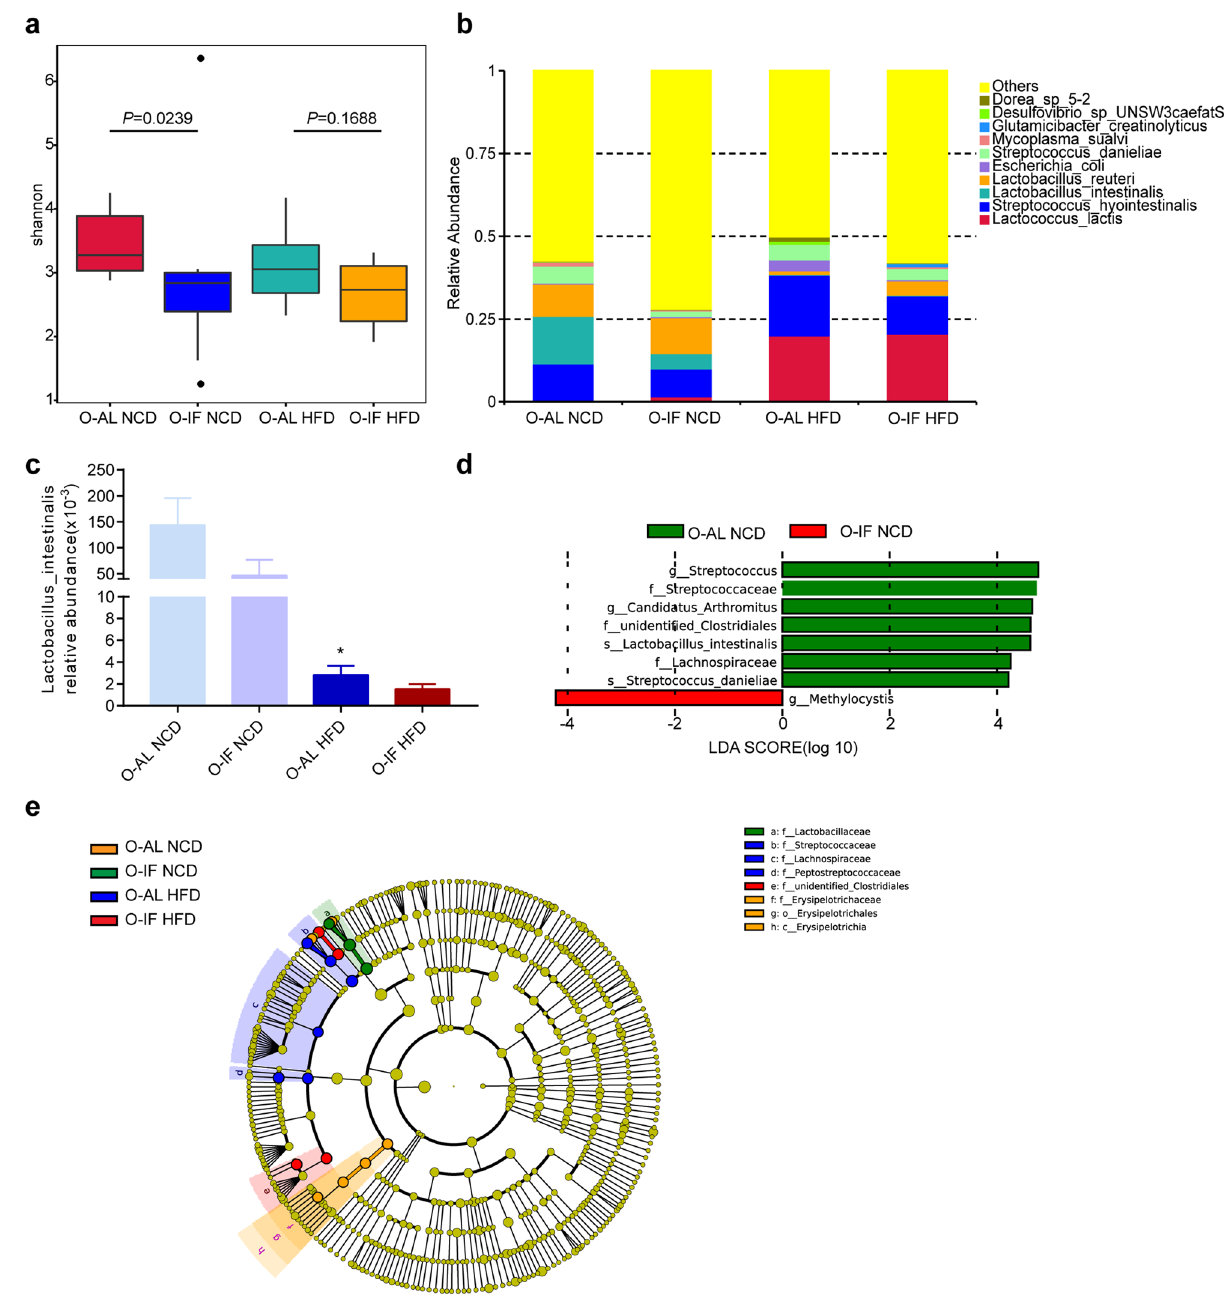
Fig. 2 Maternal intermittent fasting disrupts offspring intestinal microbiota. Six-week-old offspring of M-AL group and M-IF group were fed normal chow diet (NCD) or high fat diet (HFD) for 12 weeks. Intestinal microbiota was analyzed as described in the method section. N = 9 for O-AL NCD, 8 for O-IF NCD, 8 for O-AL HFD, and 10 for O-IF HFD. a Alpha-diversity-shannon diversity index of O-AL NCD, O-IF NCD, O-AL HFD and O-IF HFD, pairwise signi fi cance determined by Wilcoxon test. b The relative abundances of species in fecal samples. c Relative abundance of Lactobacillus_intestinalis . d The most differentially abundant taxons identi fi ed by LEfSe analysis with LDA score > 4. e Cladogram of signi fi cant changes at all taxonomic levels. The radiating circle represents the classi fi cation hierarchy from class to family. The size of node represents the abundance of intestinalis restores the intestinal barrier dysfunction in offspring of circulating triglyceride ( P = 0.0196) (Fig. 4b) were observed in maternal intermittent fasting mice. O-IF offspring. Hepatic triglyceride content ( P = 0.0456), and steatosis evidenced by H&E and oil red O staining were elevated (Fig. 4e). Fat mass and adipocyte size of perirenal white adipose tissue (rWAT), epidydimal white adipose tissue (eWAT) and subcutaneous white adipose tissue (sWAT) were increased (Fig. 4f). Administration of L. intestinalis reversed the impair- mice . We next examined the metabolic consequence of intestinal ment in glucose tolerance (Fig.4a) as well as increment in plasma barrier dysfunction in O-IF offspring fed HFD. Signi fi cant triglyceride (Fig. 4b), lipid absorption (Fig. 4c), intestinal Cd36 impairment in glucose tolerance (Fig. 4a) and increase in